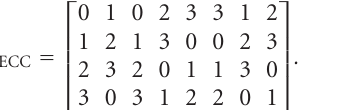
where σ 2 x = E [ | X ( k ) | ] 2 . This represents the correlation between ξ -spaced complex samples in a subblock p . The ACF